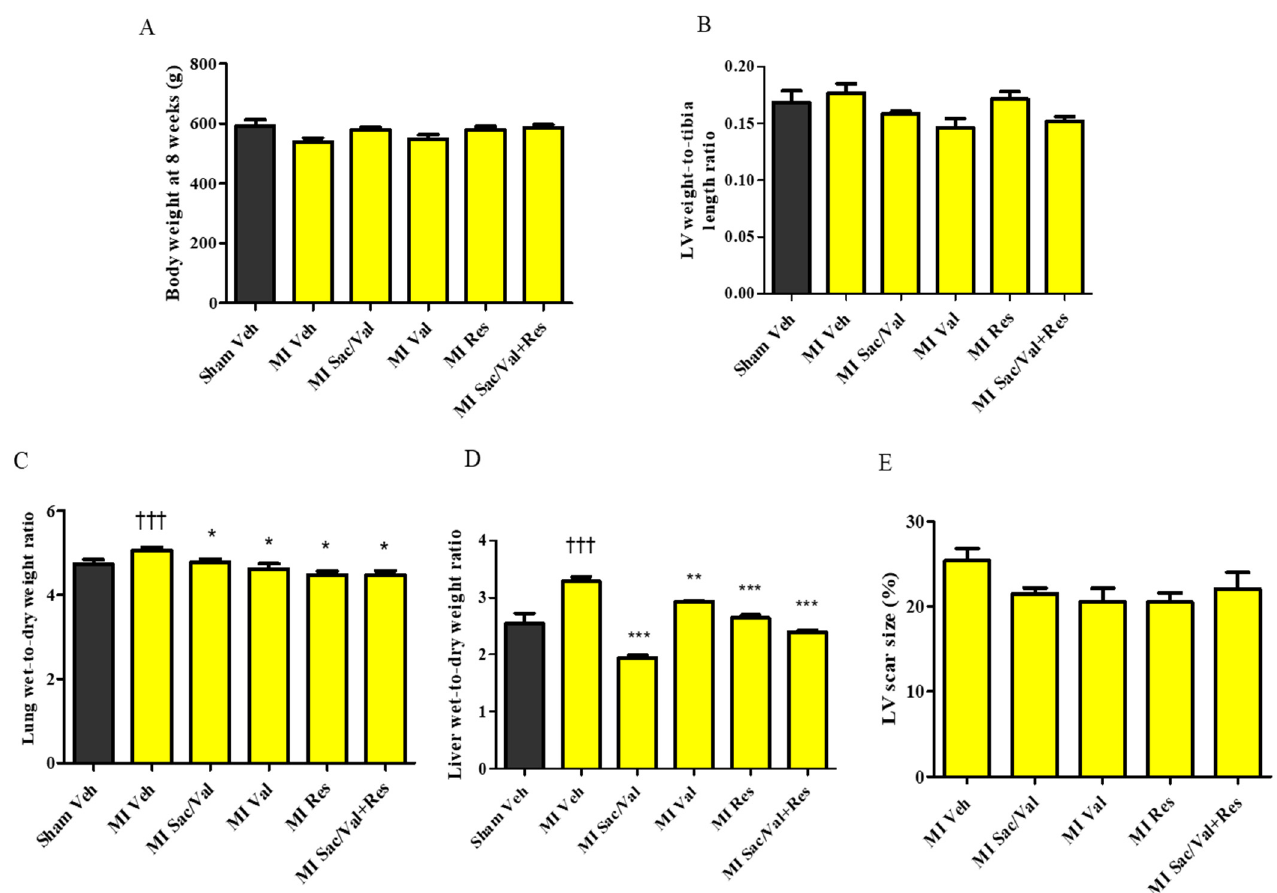
Figure 1. ( A ) Body weight of sham and MI rats at week 8; ( B ) LV weight-to-tibia length ratio of sham and MI rat; ( C ) Lung wet-to-dry weight ratio of sham and MI rats. ( D ) Liver wet-to-dry weight ratio of sham and MI rats. ( E ) LV scar size (%) in MI rats. All values are expressed as mean ± SEM, n = 9–11. ††† p <0.001 vs. Sham Veh; * p < 0.05, ** p < 0.01, *** p < 0.001 vs. MI Veh. All values are expressed as mean ± SEM. Veh—vehicle, Sac/Val—sacubitril/valsartan, Res—resveratrol, Val—valsartan.